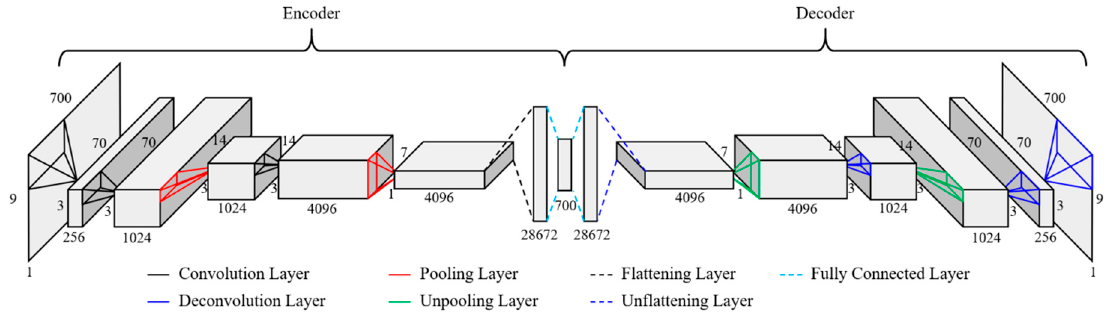
Figure 12. CAE architecture for single-vehicle traffic-load case.